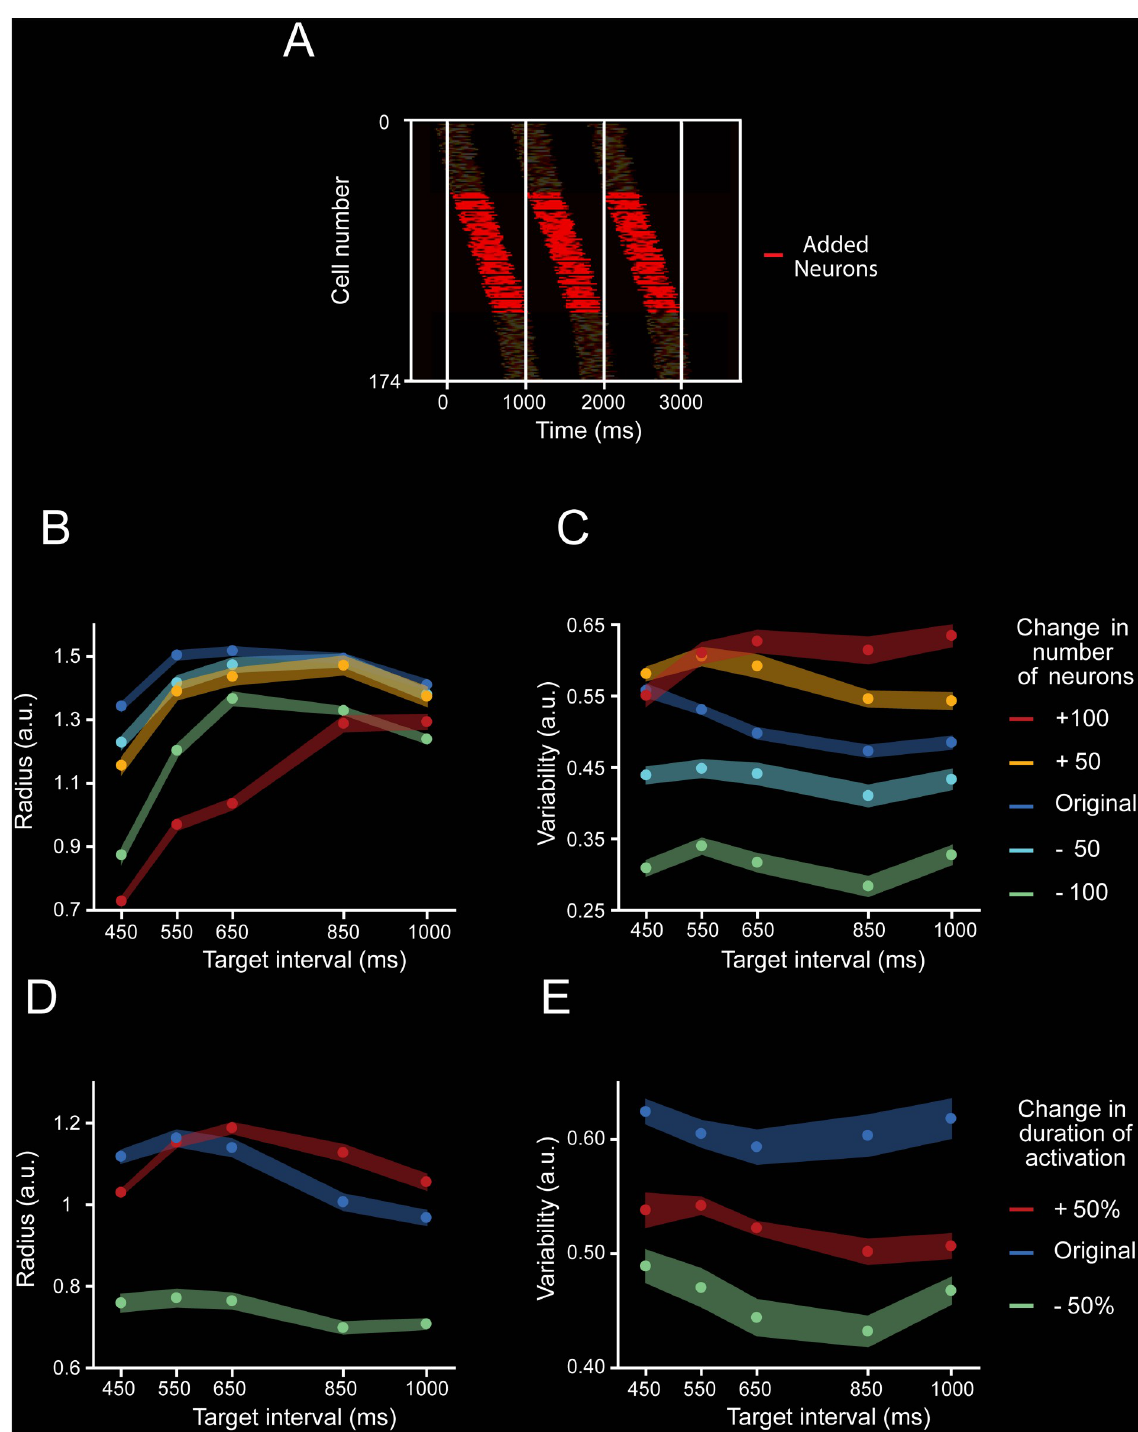
Fig 11. Moving bump simulation parameters. A. Temporal positions of the activation periods of the neurons that were included to the simulation of the 1,000-ms target interval trial (red), in addition to the position of the activation periods of neurons that also participated in the 450-ms simulation (shaded). B,C. Radius (B) and variability (C) of PCA trajectories generated from moving bump simulations when the number of neurons was modified by a constant number ( − 100, green; − 50, cyan; +50, yellow; and +100, red) from the original number of neurons (208 neurons for 450-ms target interval, 220 neurons for 550-ms target interval, 230 neurons for 650-ms target interval, 270 neurons for 850-ms target interval, and 282 neurons for 1,000-ms target interval; blue) while the activation period was kept constant at 257 ms across